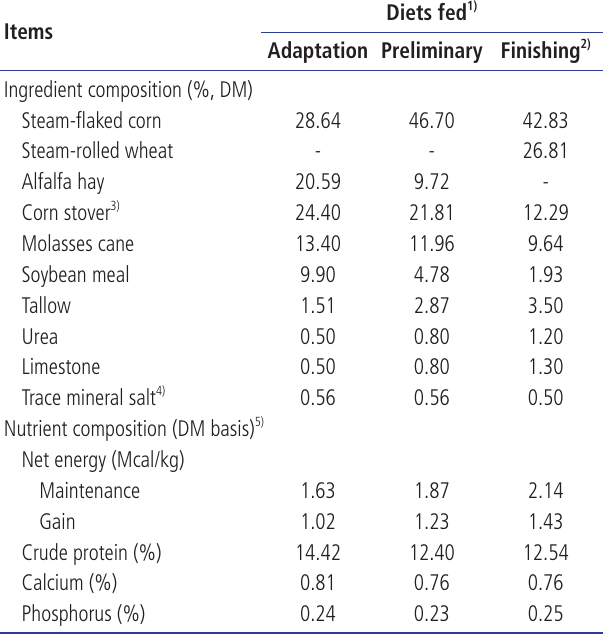
Table 1. Composition of diets fed during the course of the study